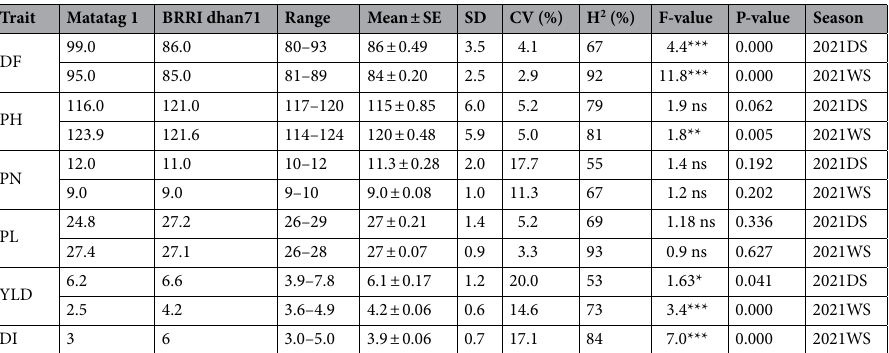
Table 3. Evaluation of BRRI dhan71 ILs for agronomic, yield and RTV resistance at IRRI-HQ. DF—days to flowering (days), PH—plant height (cm), PN—panicle number, PL—panicle length (cm), YLD—yield (t/ ha), DI—disease index, SE—standard error, SD—standard deviation, CV—coefficient of variation (%), H 2 — heritability, * P≤ 0.05, ** P≤ 0.01, *** P≤